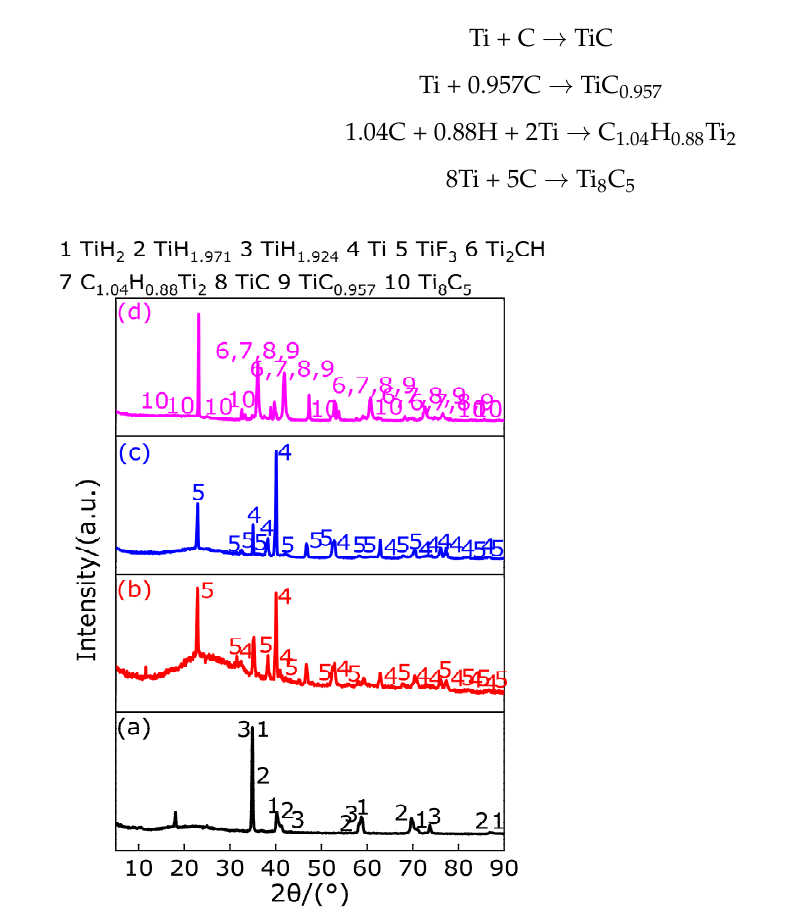
Figure 17. XRD patterns of PTFE/TiH 2 composite at different peak temperatures and 1000 °C. ( a ) XRD pattern at 340.6 °C; ( b ) XRD pattern at 554.6 °C; ( c ) XRD pattern at 597.1 °C; ( d ) XRD pattern at 1000 °C.